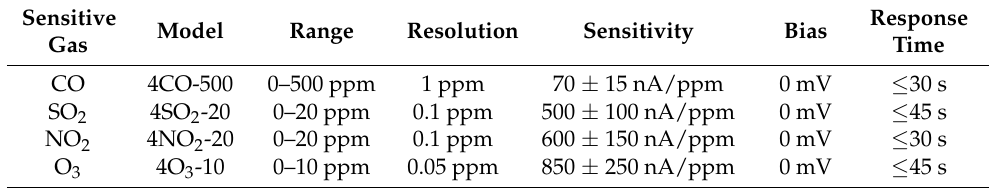
Table 1. Characteristic parameters of 4 kinds of sensors.